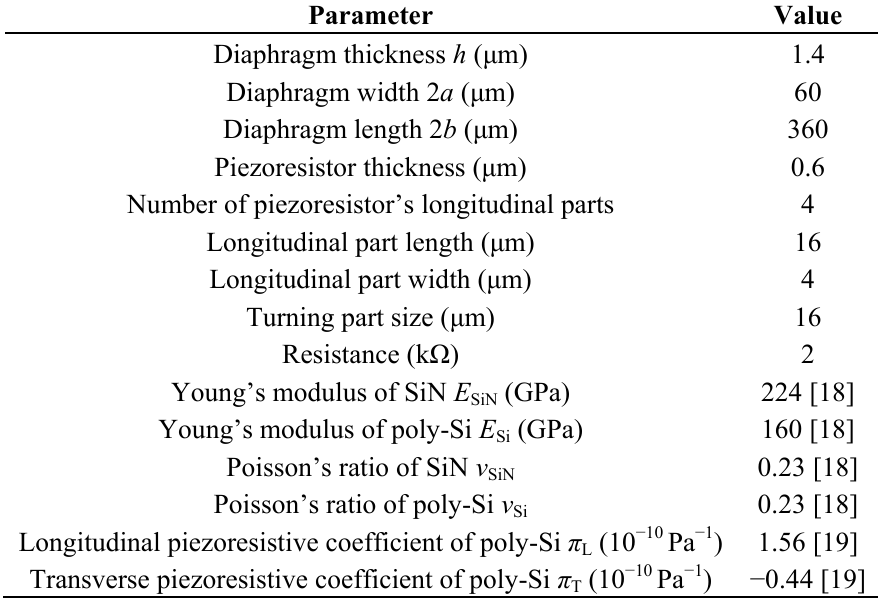
Table 1. Structure parameters and material properties of the designed piezoresistive absolute-pressure